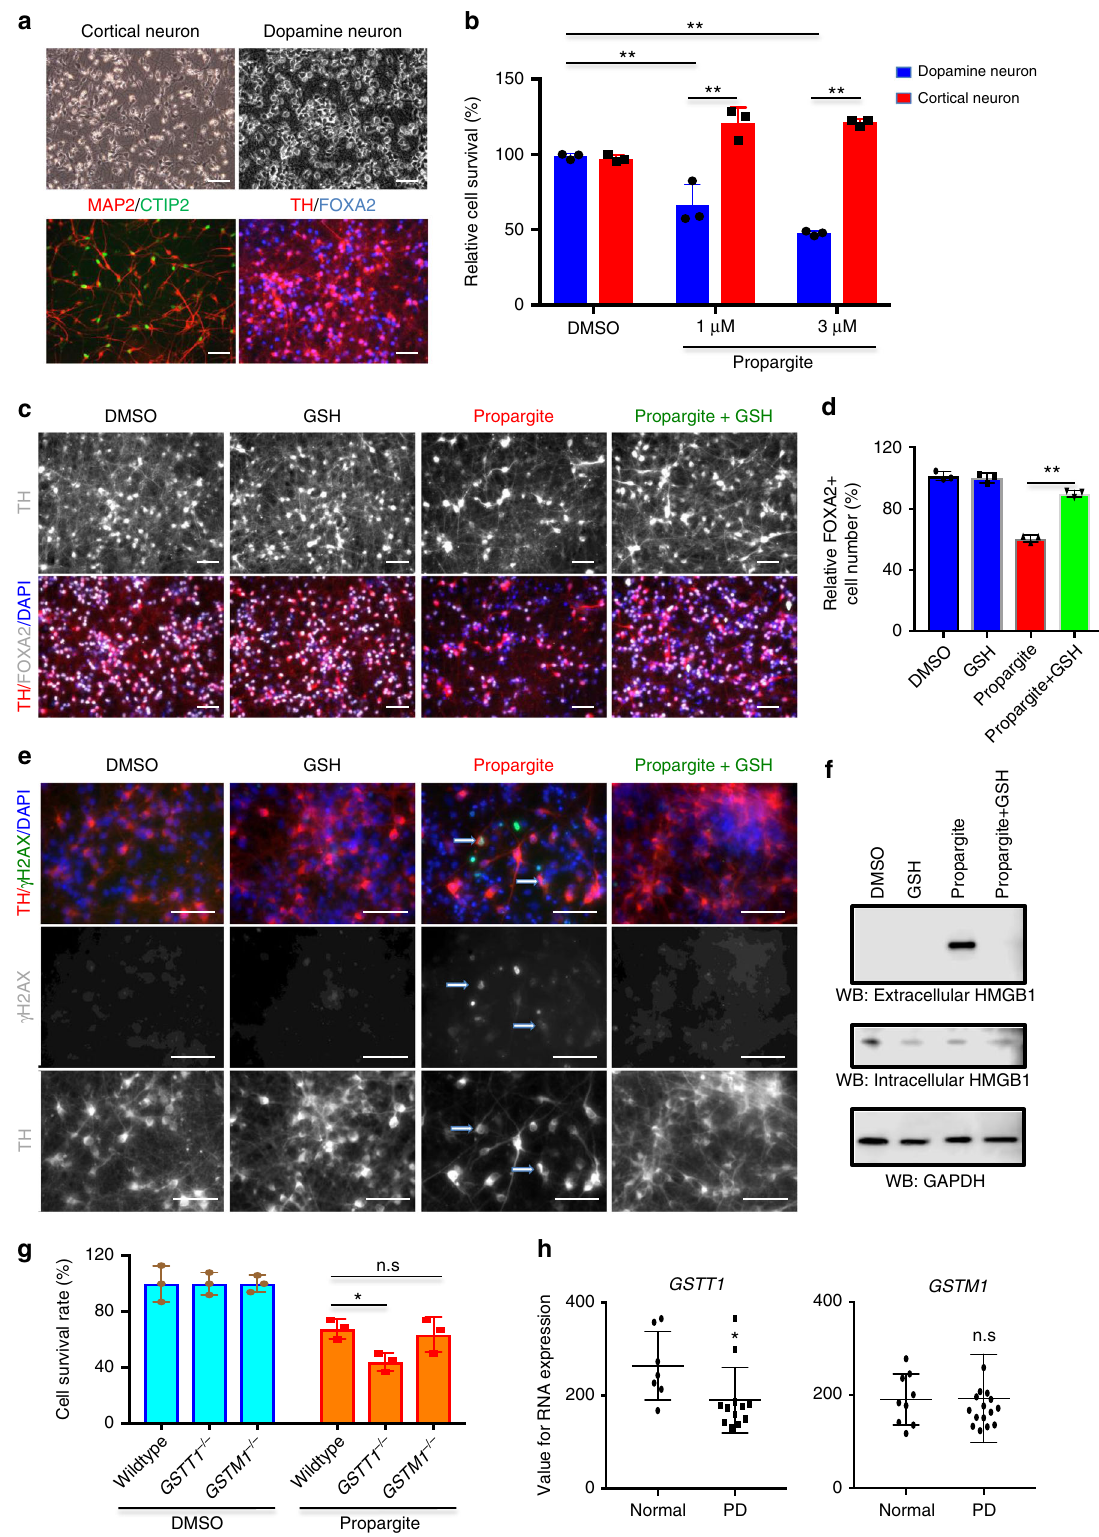
Creation of isogenic hESC lines . CRISPR sgRNA sequences were designed using the web resources available at http://www.genome-engineering.org/. The target sequences are listed in Supplementary Table 2. Each target sequence was cloned into the pX330-U6-Chimeric_BB-CBh-hSpCas9 vector (Addgene plasmid #42230) to make the gene targeting constructs. To knockout the target genes, two sgRNAs were validated using the surveyor assay in 293T cells, and we chose 1 sgRNA- construct plasmid for further experiments. After validation, H1 or INS GFP/W HES3